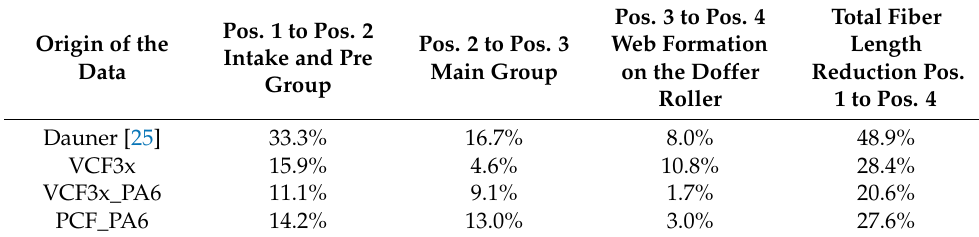
Table 9. Length reduction by position in